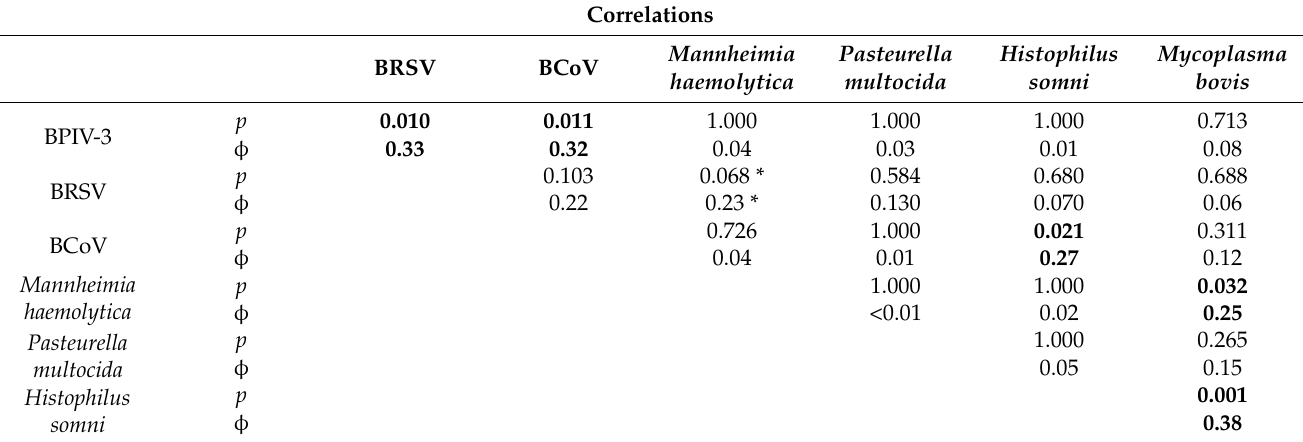
Table 1. The table shows the correlations between the occurrence of the pathogen pairs studied. Statistically significant correlations and their strength of effect are highlighted in bold. All marked correlations were positive. p denotes statistical significance; φ denotes a Phi contingency coefficient indicating the strength of effect of a given association. * denotes that the correlation shown is inverse.